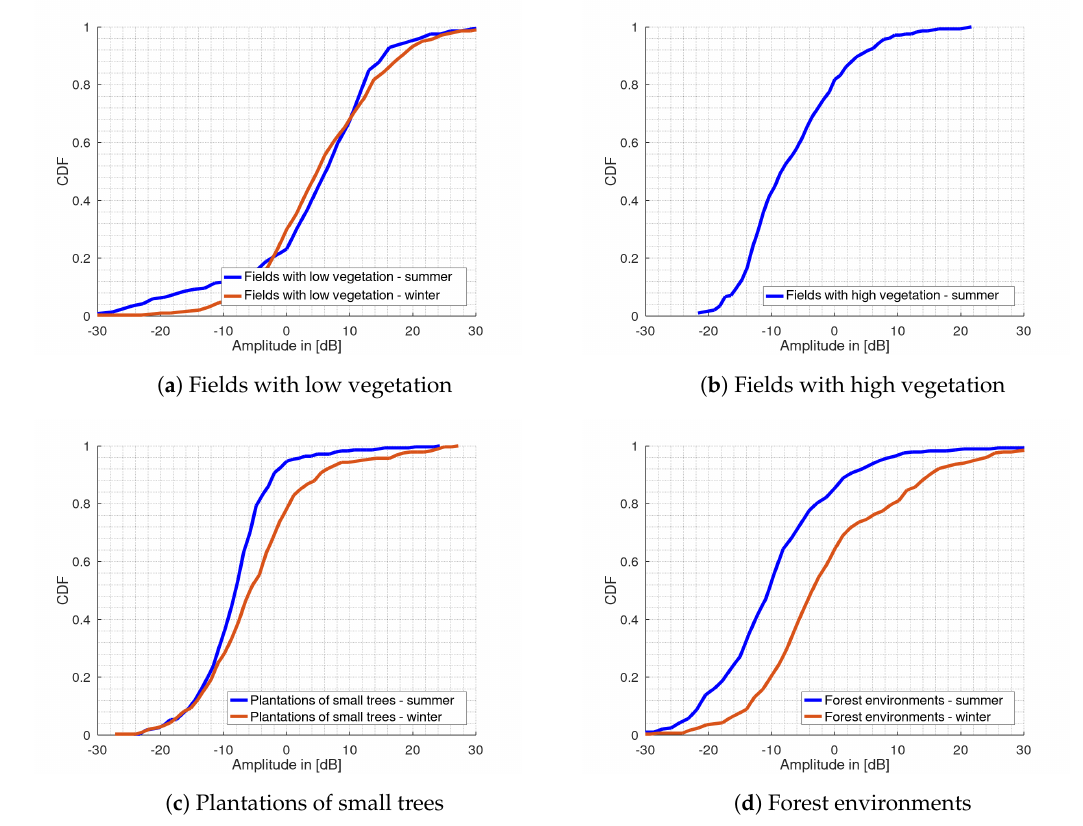
Figure 7. Cumulative distribution function plots of the clutter amplitudes for summer and winter for ( a ) fields with low vegetation, ( b ) fields with high vegetation, ( c ) plantations of small tress and ( d ) forest